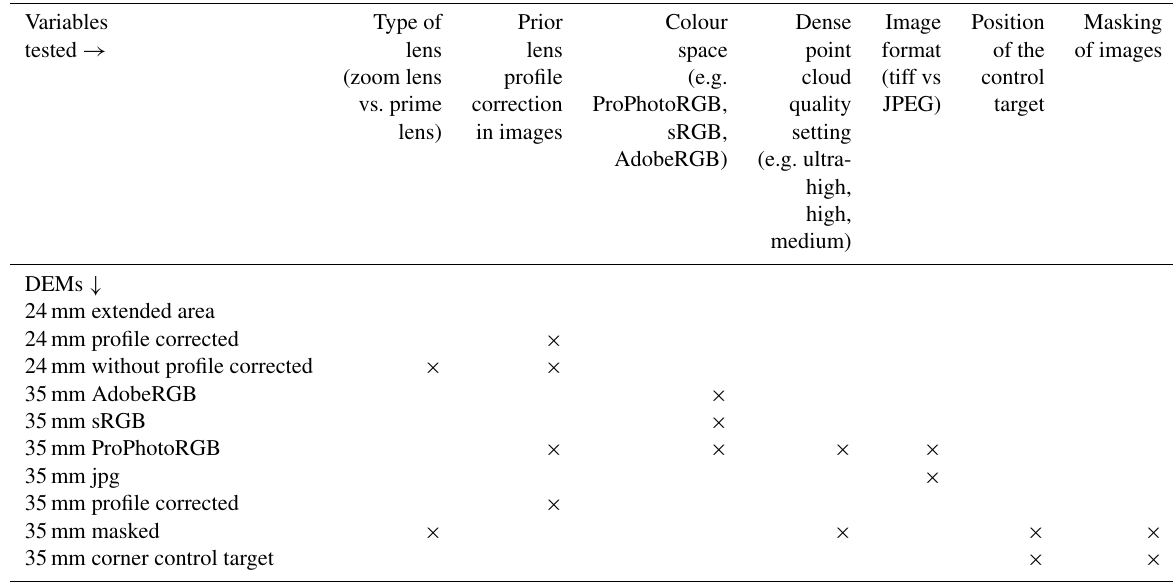
Table 3. Experimental design used in error evaluation experiment. Crosses represent the DEMs compared for a variable. Variables Type of Prior Colour Dense Image Position Masking tested → lens lens space point format of the of images (zoom lens profile (e.g. cloud (tiff vs control vs. prime correction ProPhotoRGB, quality JPEG) target lens) in images sRGB, setting AdobeRGB) (e.g. ultra- high, high, medium) DEMs ↓ 24mm extended